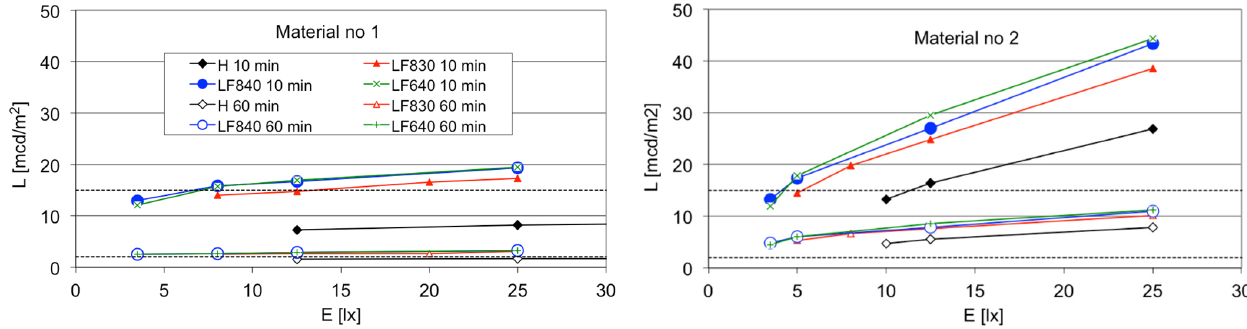
Figure 4. Changes in luminance values measured 10 and 60 min after the excitation source goes off for four lamps and two materials.